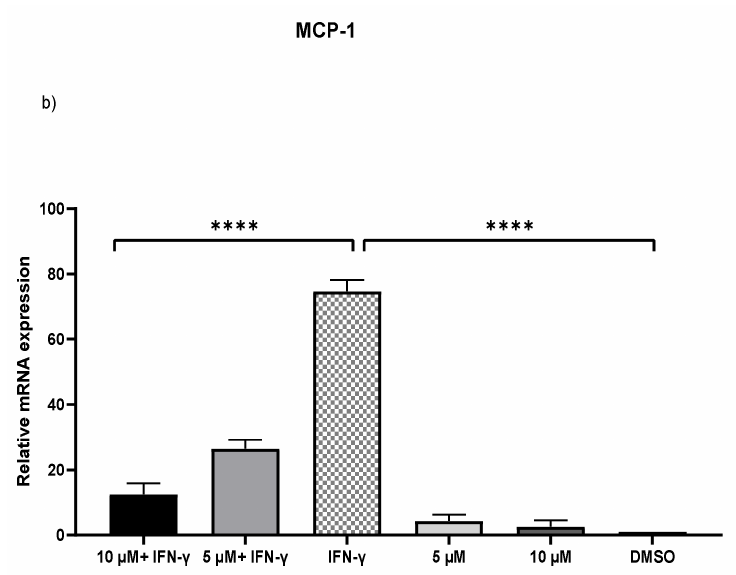
Figure 2. Kaempferol significantly prevents IFN- γ -triggered overexpression of ICAM-1 and MCP-1. To amplify complementary DNA, gene-specific primer sequences were utilized. The mean standard deviation of three separate experiments is reported. Statistical significance was determined by one-way ANOVA, with *** p ≤ 0.001, **** p ≤ 0.0001.